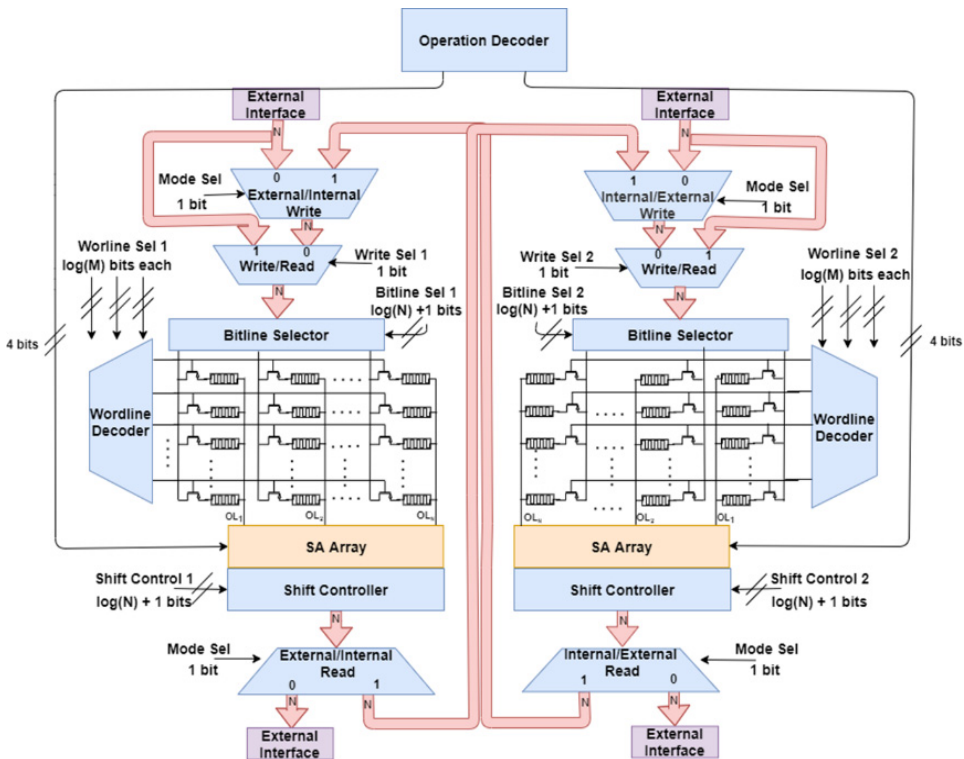
Figure 6. Block level description of the proposed computational memory, consisting of a symmetric segmented structure with two “twin” 1T1R crossbar sub-arrays with dedicated peripheral circuitry and control signals. Adapted from Reference [19].